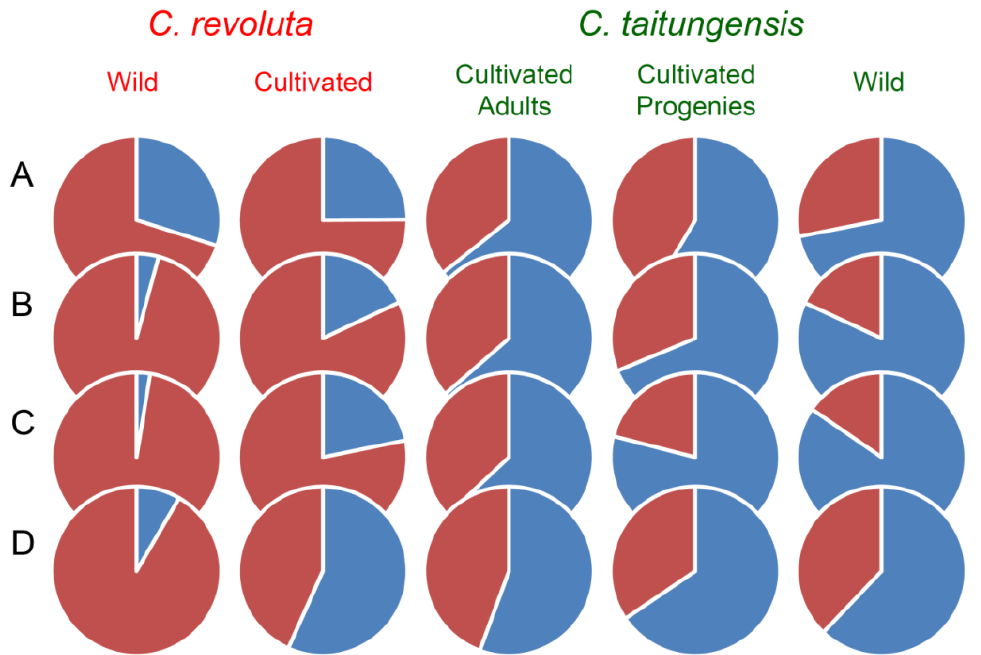
Figure 4. Average genetic composition of wild populations and cultivated samples of C. revoluta and C. taitungensis , detected by ( A ) 262 neutral loci; ( B ) species-associated loci at criteria LOD 3.0; and ( C ) LOD 6.0; and ( D ) the loci of linkage subgroup 1 of LOD